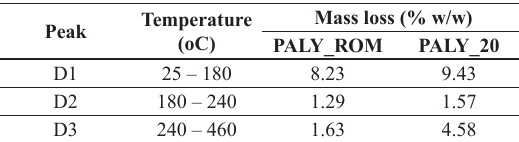
Table 3. Mass loss of samples PALY_ROM and